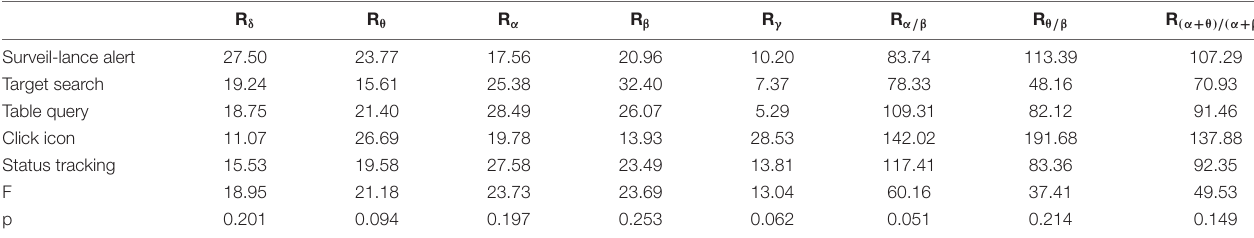
TABLE 4 | Results of EE parameters (first 5 rows:%).